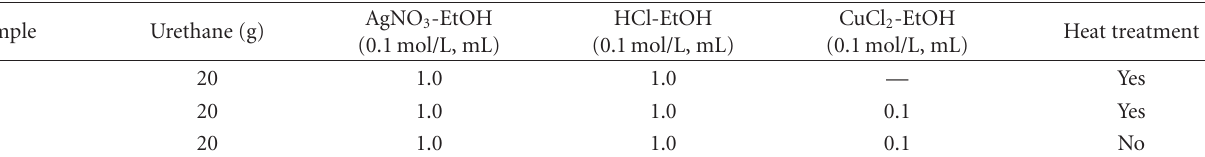
Table 1: Synthesis conditions of AgCl-resin photochromic composite films.